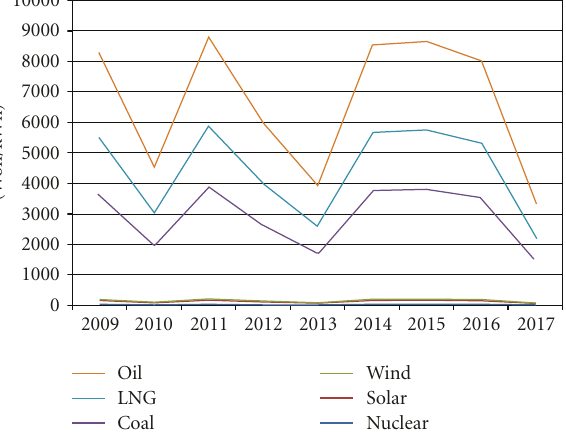
Figure 28: Emission costs on energy